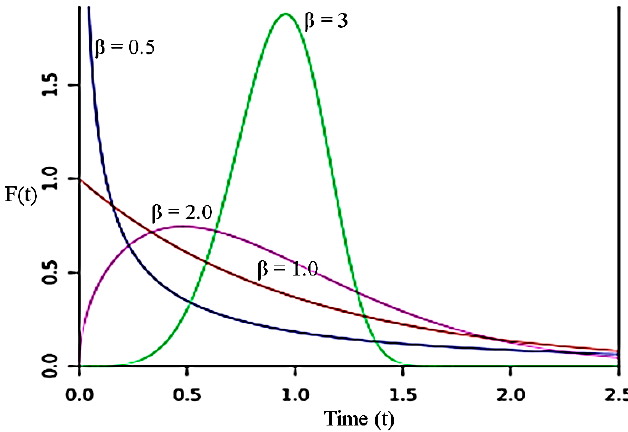
Figure 3. Weibull PDF curve with varying β values.